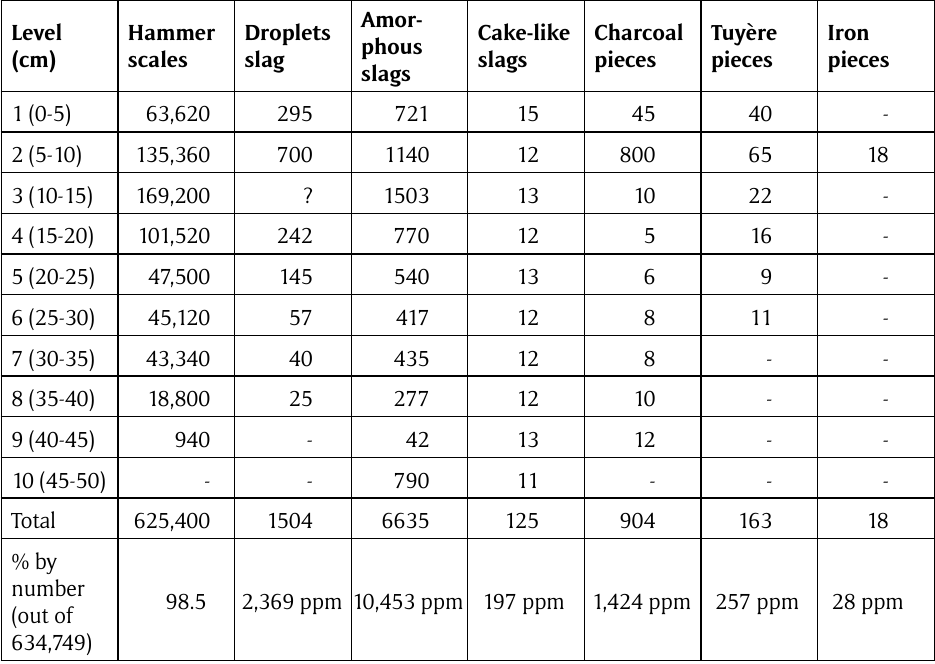
Table 1: Summary of the Nundu Unit 1 material by number. No.